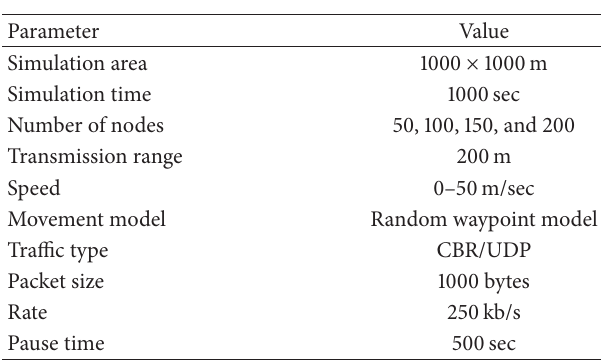
Table 1: Parameter settings for simulation.